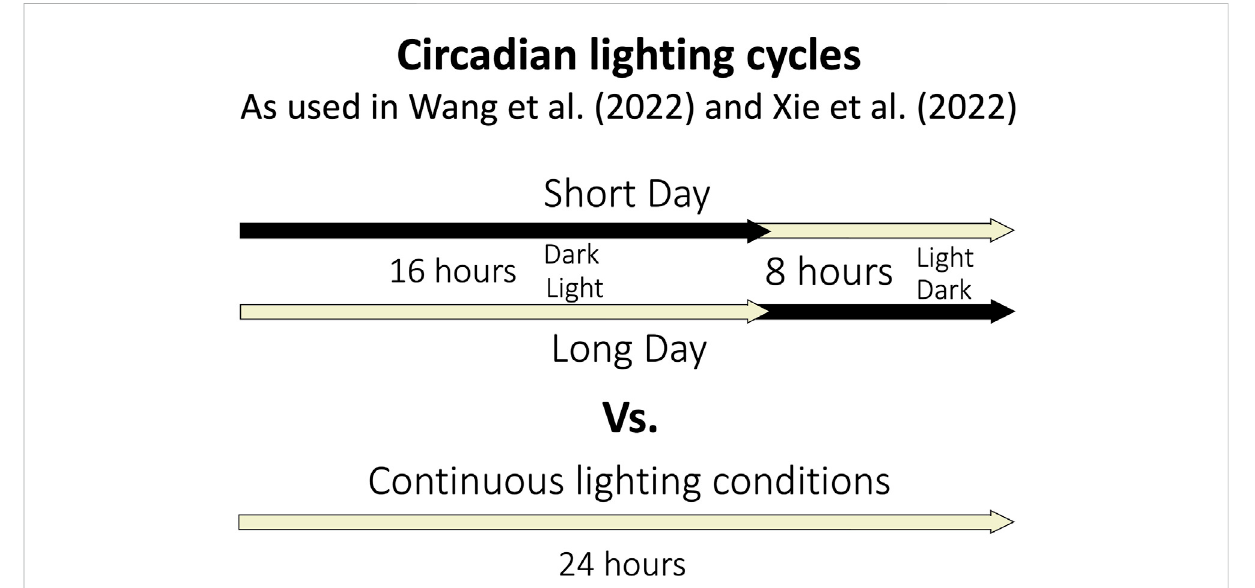
FIGURE 3 Depiction of the lighting timing for circadian and continuous lighting conditions in selected space fl ight